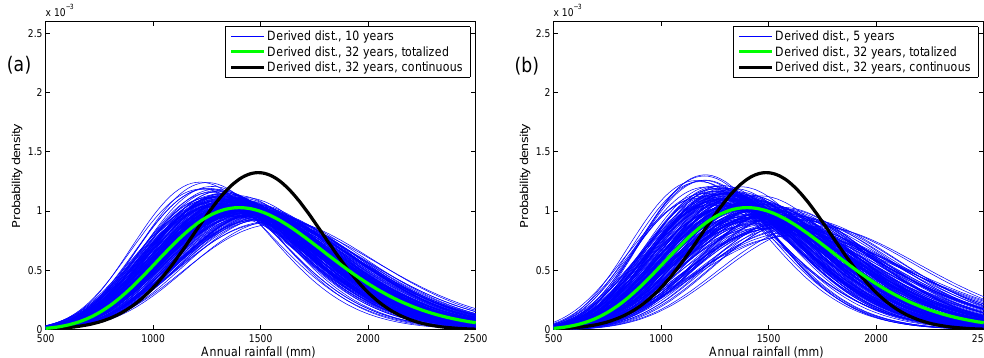
Figure 13. Estimated pdfs for 10-year (a) and 5-year (b) subsamples using a 24h totalized record in